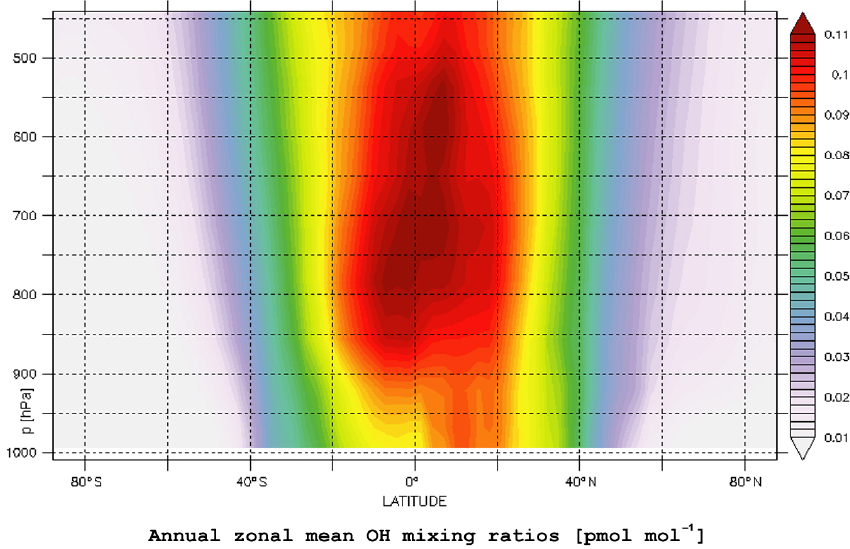
Figure 6. In the Northern Hemisphere lower troposphere, the OH mixing ratios are considerably higher than on the Southern Hemisphere. Table 2. Statistical evaluation of CARIBIC flight methane samples vs. EMAC model simulation results based on optimized emissions. Flight region: Europe Africa Far East India North America South Am. north South Am. south Globe